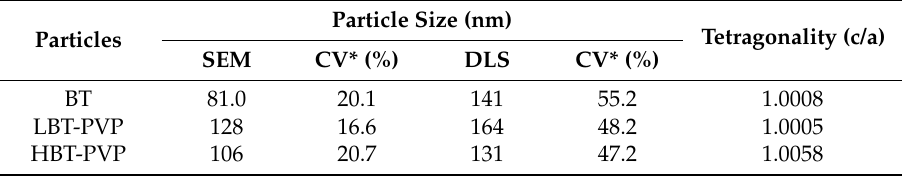
Table 1. Comparison of BT, LBT-PVP, and HBT-PVP particles size and tetragonality. Average particle size was measured by SEM and Dynamic light scattering (DLS) using ethanol (EtOH) suspensions with 5 wt %